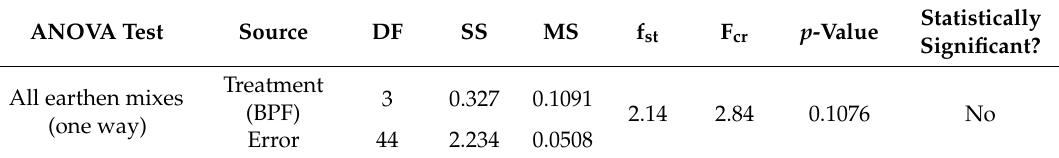
Table 6. 5% significance level ANOVA tests for the compressive strength of earthen mixes at 28 days.